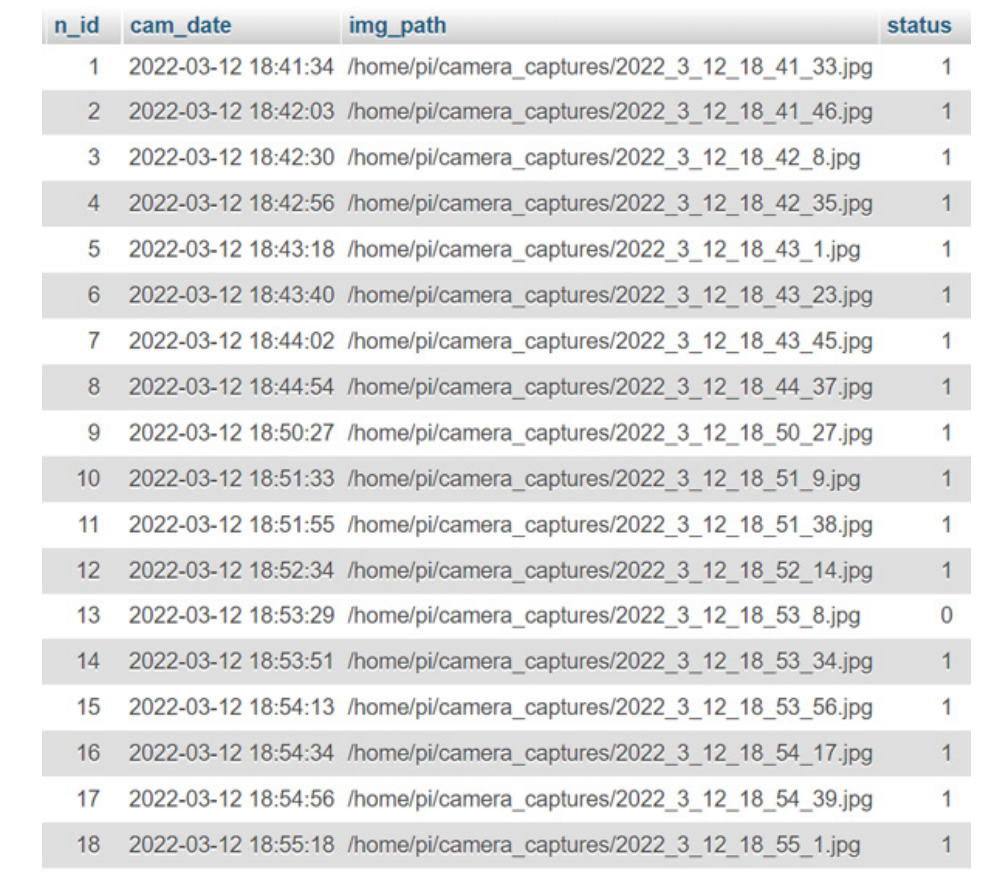
Figure 11. The record of the status of scene change detection in the database.